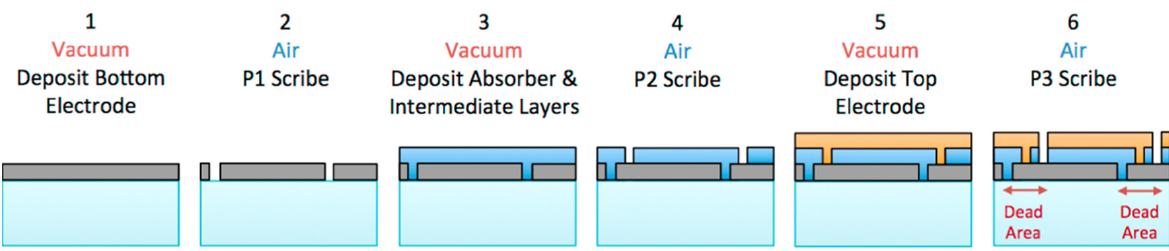
Figure 16. Fabrication for monolithic-cell integration using the conventional PV module, including an active area and a dead area consisting of the interconnections P1, P2, and P3. Reprinted with permission from ref. [47]. Copyright 2017 Elsevier.